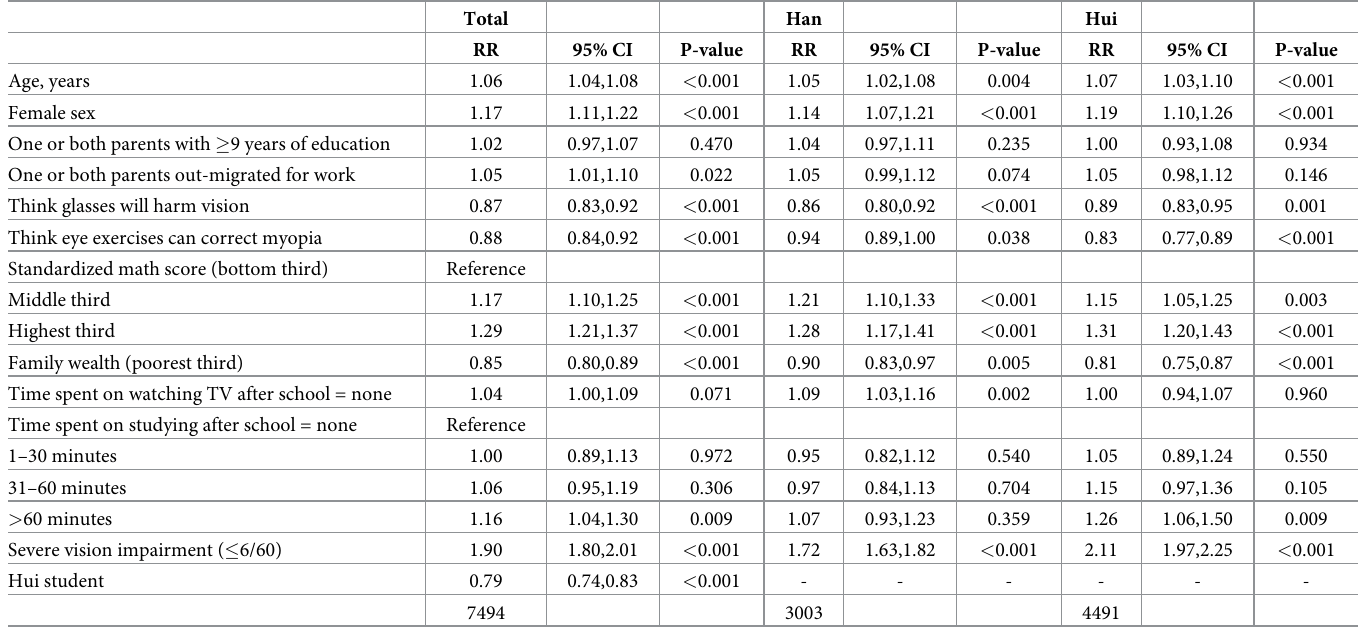
Table 4. Multivariate model: Potential associations with self-reported glasses ownership among students with uncorrected visual acuity < = 6/12 in both